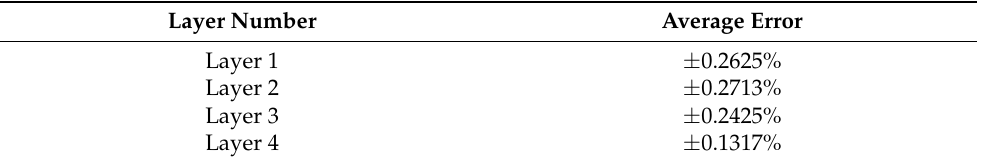
Table 8. The average errors of the grain moisture measurements.